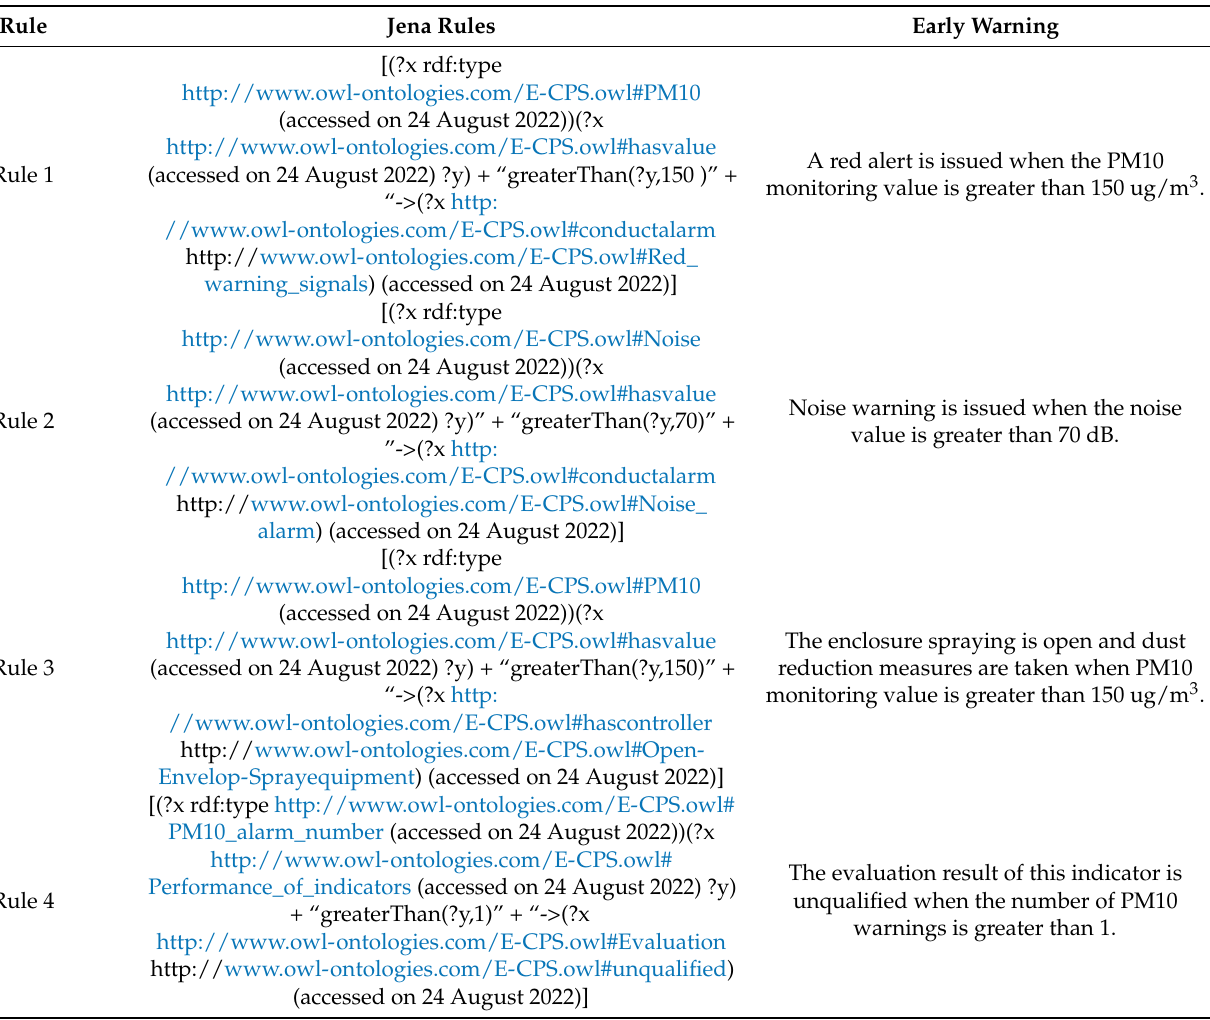
Table 4. Jena inference rules of early